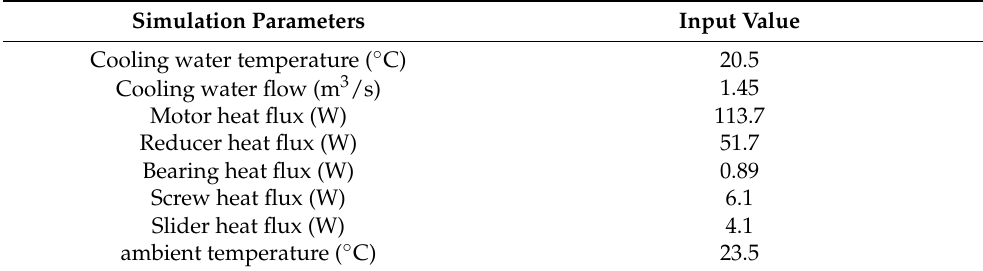
Table 4. Simulation parameters of the whole